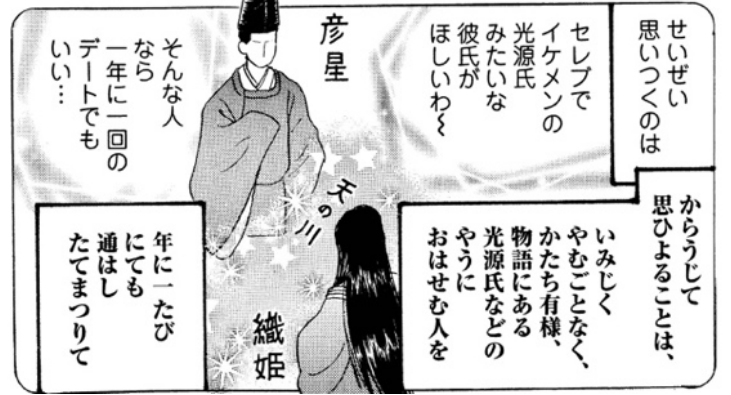
Figure 15. Heroine dreams about being visited once a year by someone like Genji (Shimizu 2014, 58). Courtesy of Futabasha.